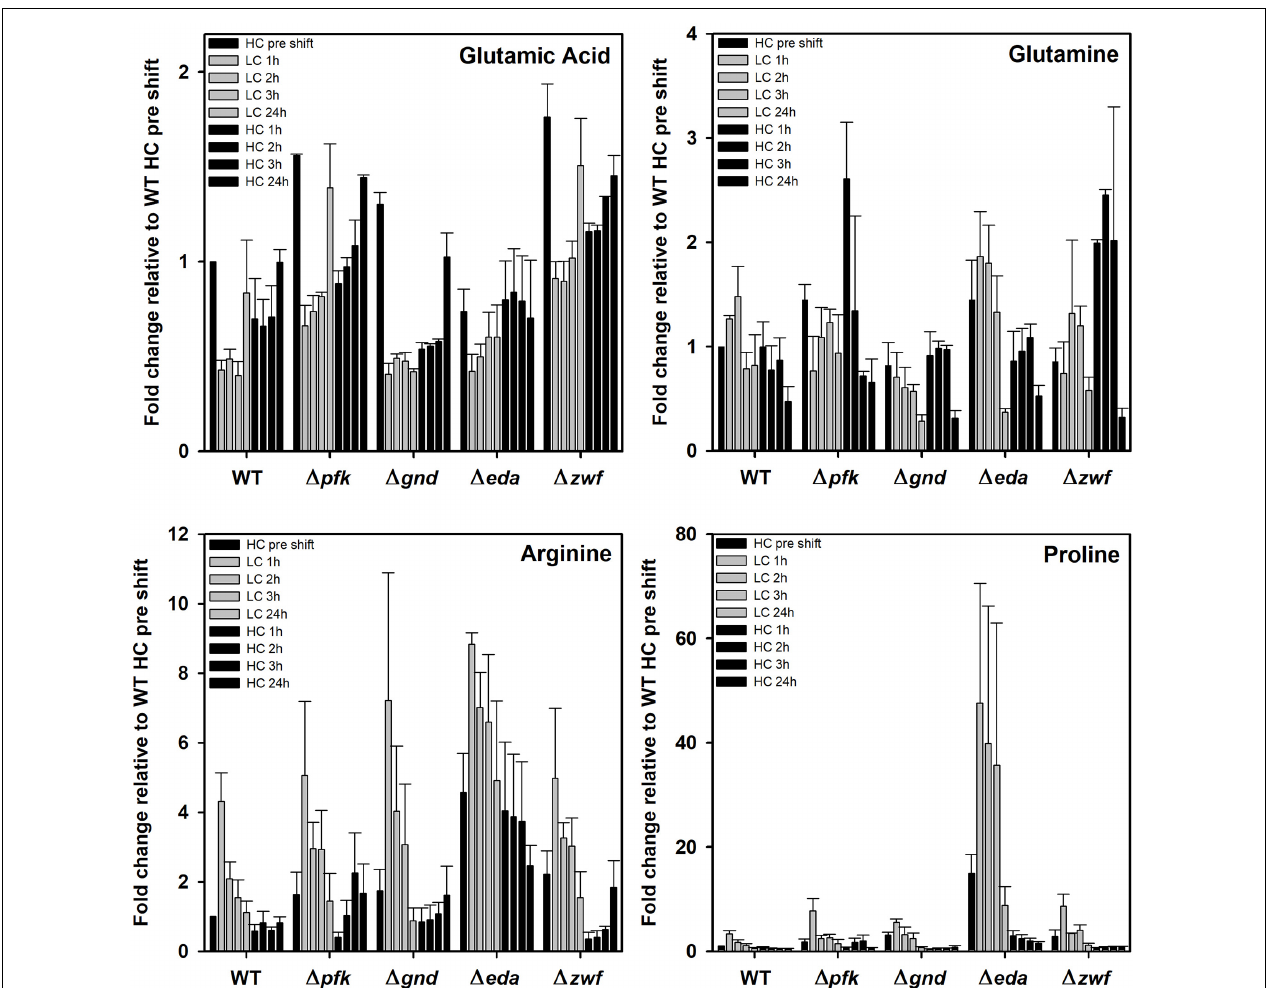
FIGURE 8 | Changes in selected amino acids in different strains during HC-LC-HC shifts. Alterations in the contents of glutamic acid, glutamine, arginine, and proline are given as fold changes relative to wild-type values (WT, HC pre shift was set to 1) under HC conditions at the beginning of the HC-LC-HC shift experiment. Mean values and standard deviations of fold changes are displayed from all three independent